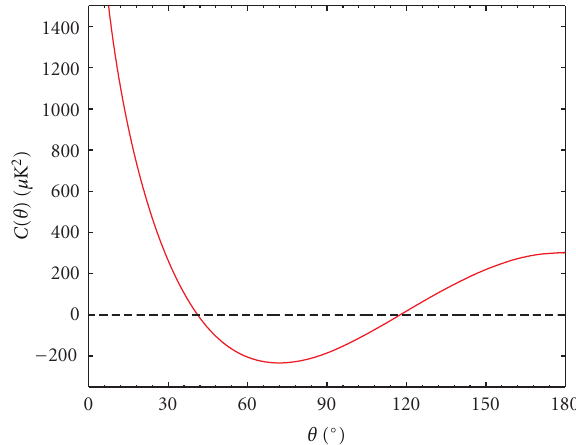
Figure 22: The angular correlation without odd-parity preference (i.e., (26)).